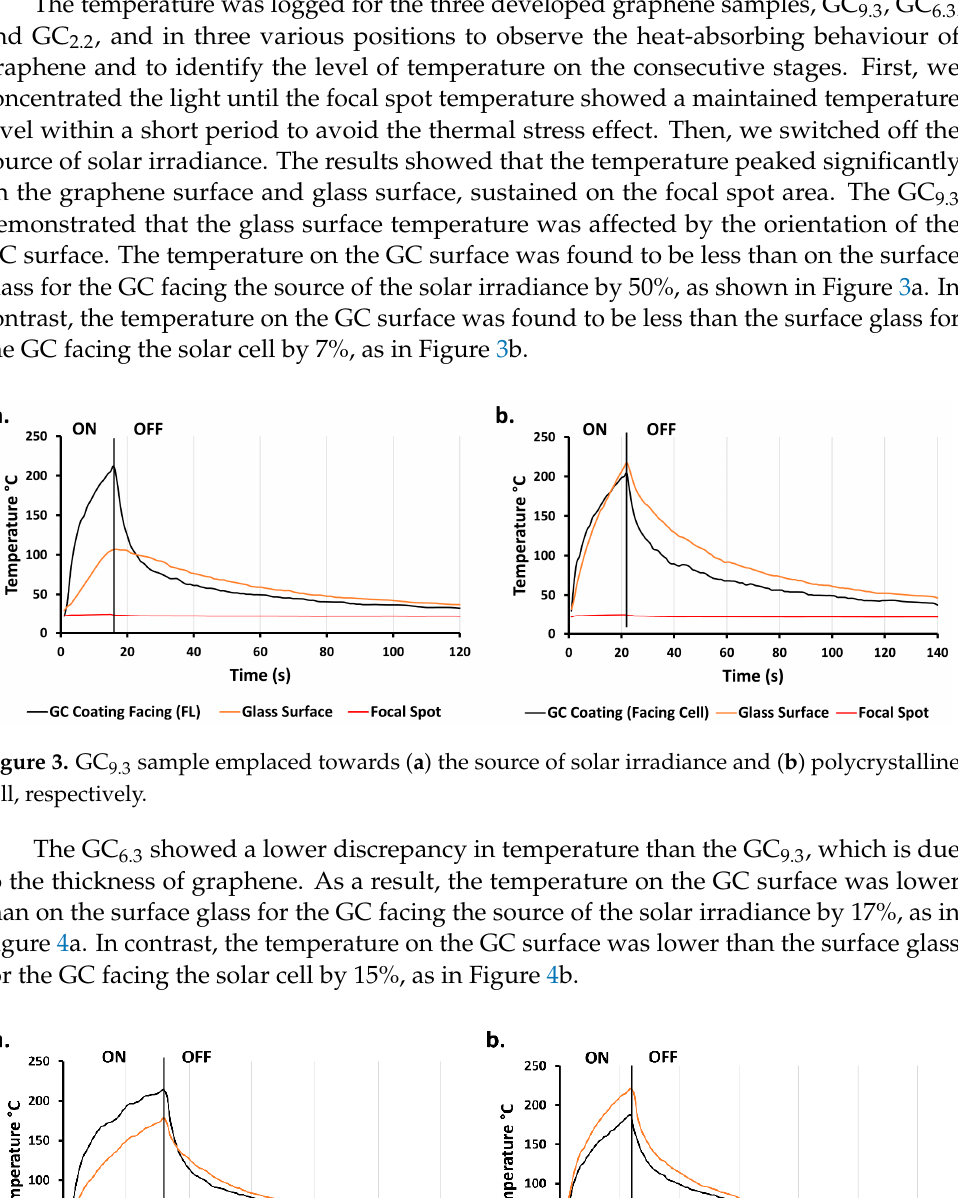
Figure 2. Schematic representation for the entire experimental set-up summarising the experi- mental approach in which ( a ) graphene coating (GC) faces the source of the concentrated solar irradiance (Fresnel lens) and ( b ) GC faces the solar cell.